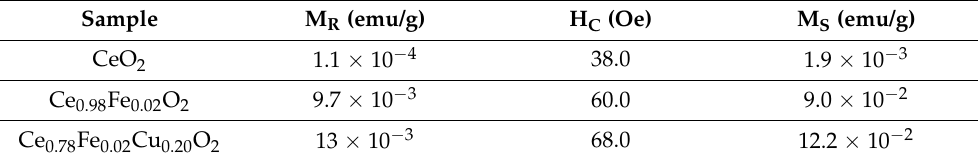
Figure 5. ( a , b ) M-H plots of CeO 2 , Ce 0.98 Fe 0.02 O 2 , and Ce 0.78 Fe 0.02 Cu 0.20 O 2 nanoparticles. Inset-1 shows the M-H curve of pure CeO 2 nanoparticles along with diamagnetic contribution in the field range of ±6000 Oe. Inset-2 represents the M-H curve of CeO 2 nanoparticles in low-field range (±500 Oe). Inset-3 represents the M-H curve of Ce 0.98 Fe 0.02 O 2 and Ce 0.78 Fe 0.02 Cu 0.20 O 2 nanoparticles in low-field range ( ± 500 Oe). Table 2. The values of various parameters, such as coercive field (H C ), remanence magnetization (M R ), and saturation of magnetization (M S ) obtained through dc-magnetization-measurements analysis of pure CeO 2 , doped CeO 2 , and co-doped CeO 2 .